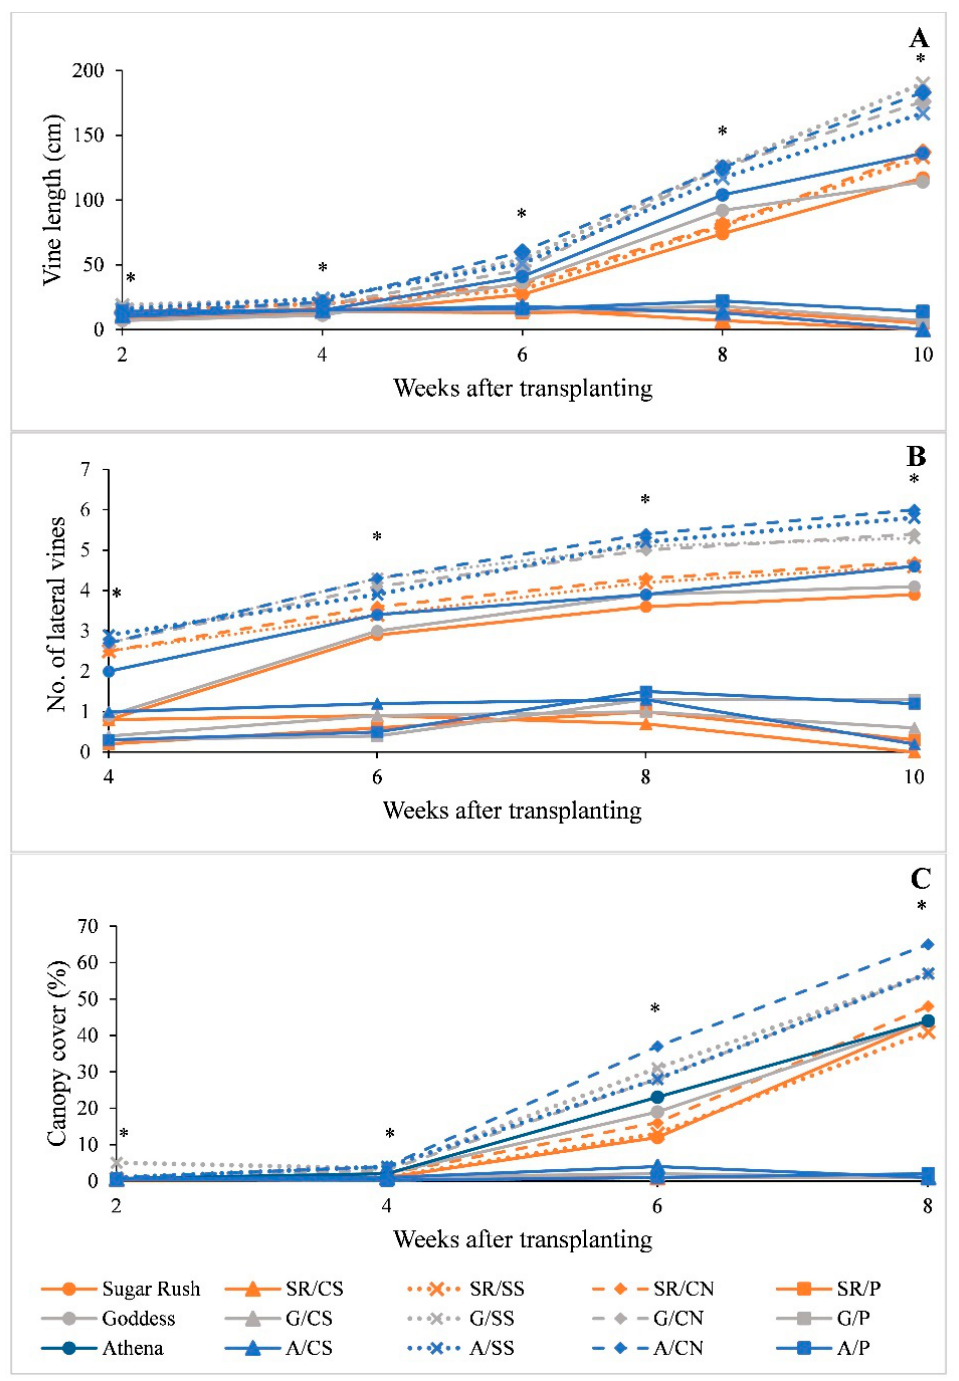
Figure 3. Vine length ( A ), number of lateral vines ( B ), and percent canopy cover ( C ) of cantaloupe cultivars Sugar Rush (SR), Goddess (G) and Athena (A) nongrafted and grafted onto four rootstock cultivars Carolina Strongback (CS), Super Shintosa (SS), Carnivor (CN), and Pelop (P) grown with black soil-biodegradable plastic mulch (BDM) and measured every two weeks until 10 weeks after transplanting from 1 June to 15 August 2020 and 20 May to 31 July 2021 (years combined) at Mount Vernon, WA, USA. * represents significant differences at p < 0.05.